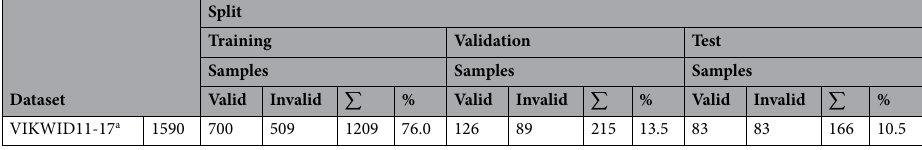
Killer whale dorsal fin/saddle patch extraction (FIN‑EXTRACT).